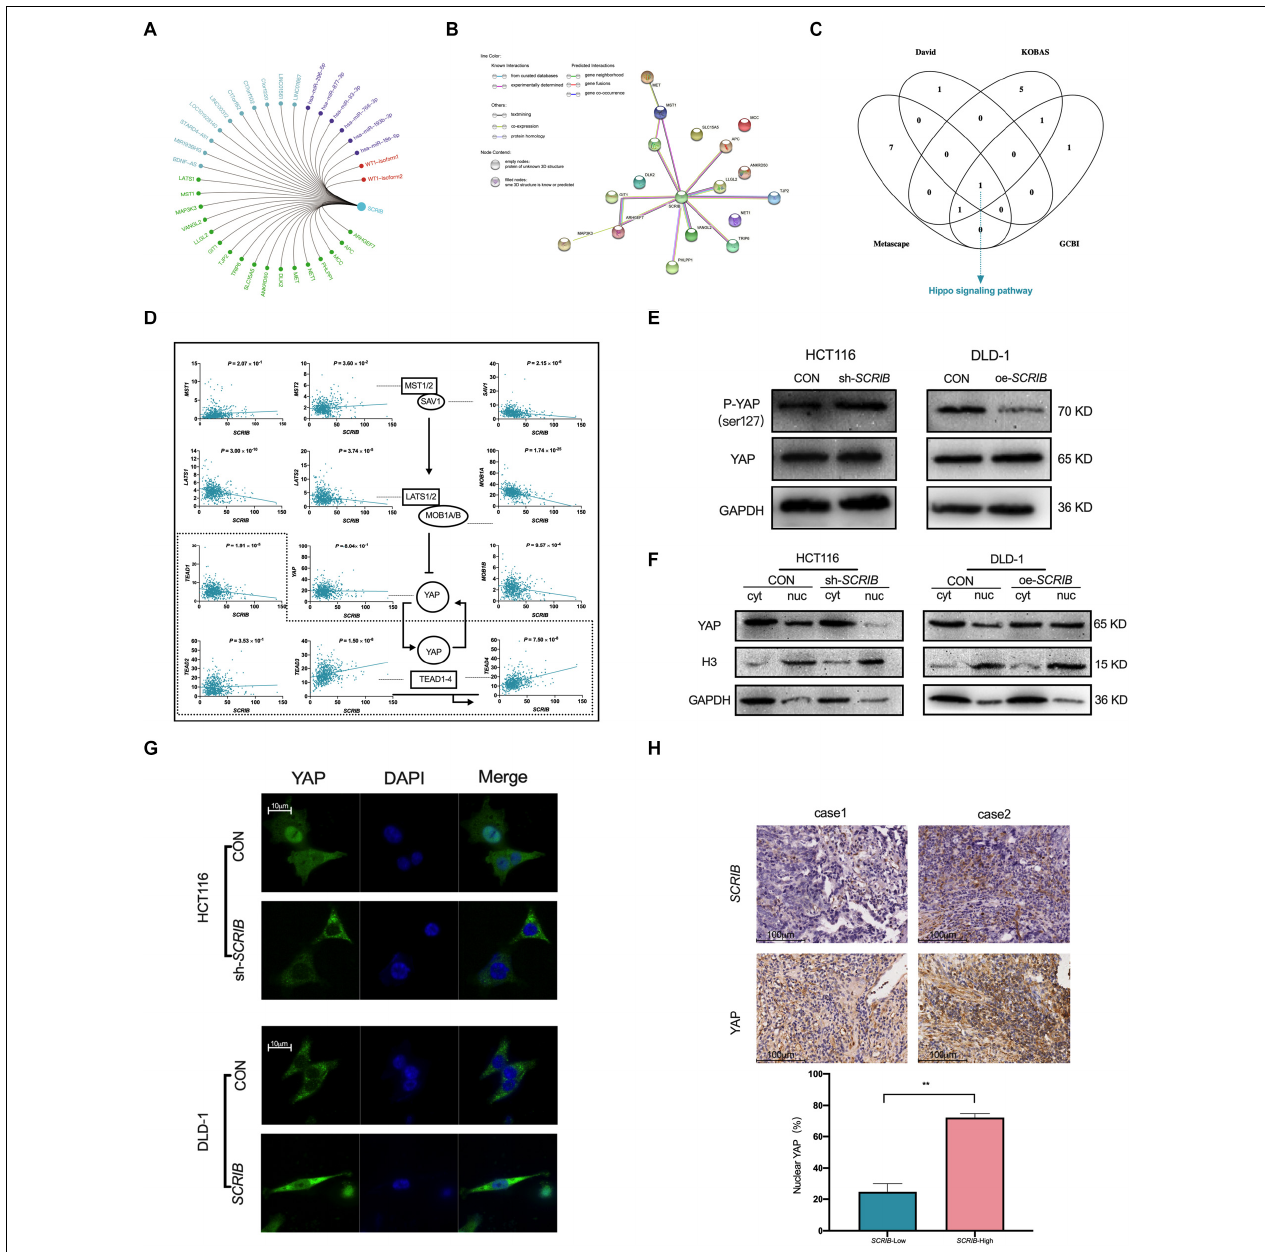
FIGURE 5 | | SCRIB promotes the Hippo/YAP signalling pathway in CRC cells. (A) SCRIB -related regulatory network. Green represents interacting proteins, light blue represents related lncRNAs, purple represents targeted miRNAs, and red represents activated transcription factors. (B) Interactions between proteins predicted by the STRING database. The empty nodes represent the 3D structure position of the protein, and the filled nodes represent the known or predicted 3D structure of the protein. Proteins determined to be related to each other are connected by light blue and dark purple, and these relations have been verified by databases and experiments, respectively. Among the predicted protein interactions, dark green represents the gene neighbourhood, red represents gene fusions, and dark blue represents gene cooccurrence. The remaining lines represent weaker connections between proteins: light green represents text mining, black represents coexpression, and light purple represents protein homology. (C) David, KOBAS, Metascape and GCBI were used to predict the downstream pathways of SCRIB , and the Hippo signalling pathway was the only signalling pathway identified in all four databases. (D) The correlation between SCRIB and the core genes of the Hippo signalling pathway was analysed through the TCGA database. The dashed box indicates the nucleus. A straight arrow indicates activation, and a straight blunt arrow indicates inhibition. (E) Nuclear and cytoplasmic protein separation from the indicated CRC cells was performed to detect the expression of YAP by western blotting. Histone H3 and GAPDH were used as the loading controls for nuclear proteins and cytoplasmic proteins, respectively. (F) Cell lysates from the indicated cells were subjected to immunoblotting for phosphorylated YAP (Ser127) and total YAP. (G) Representative images showing the influence of different expression levels of SCRIB on the intracellular distribution of YAP; scale bar: 10 µ m. (H) Representative images of immunohistochemical staining for SCRIB and YAP in sections from CRC tumours, scale bar: 100 µ m. ** P < 0 . 01.